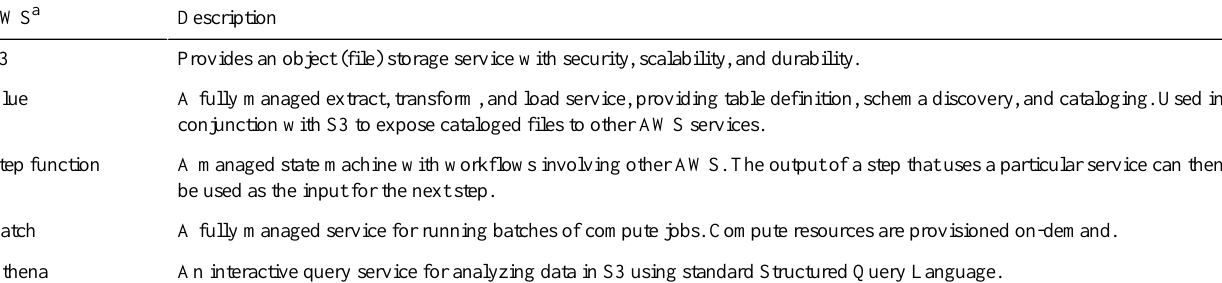
Table 2. Amazon Web Services